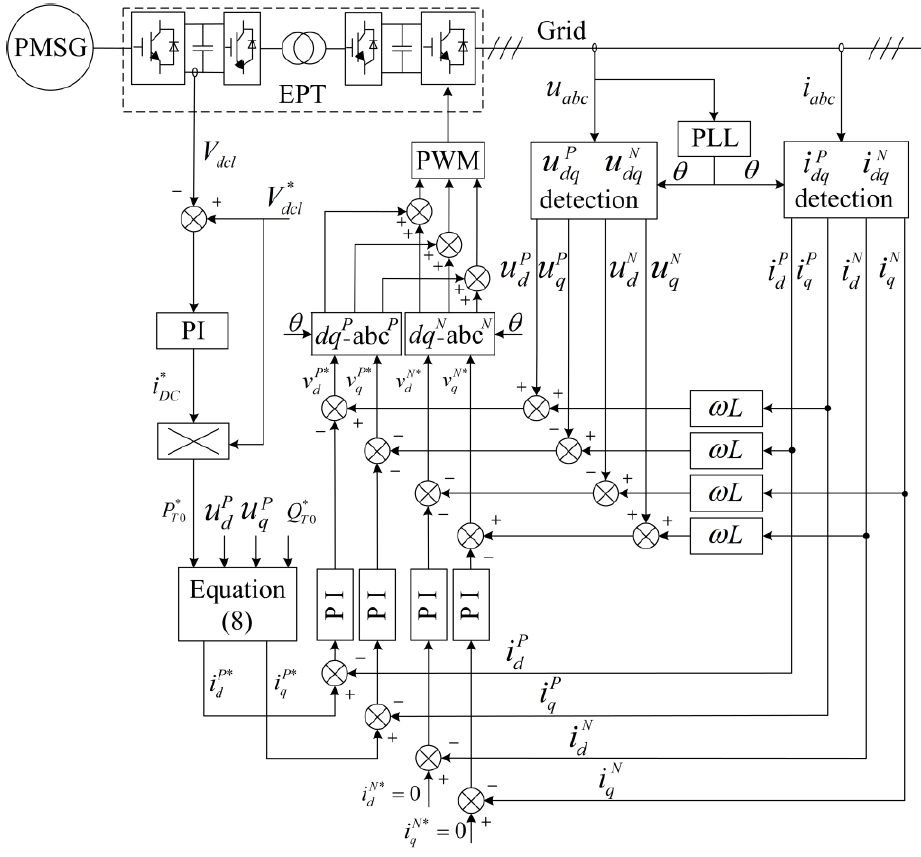
Figure 6. Control strategy of the grid side converter.